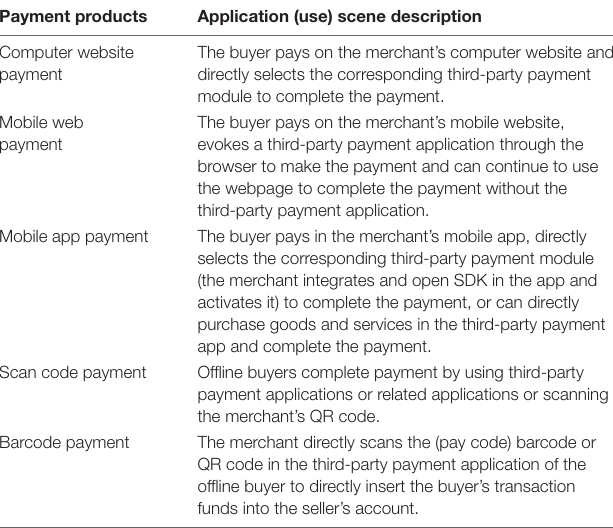
TABLE 1 | Instructions for the main payment products of the third-party payment platform in